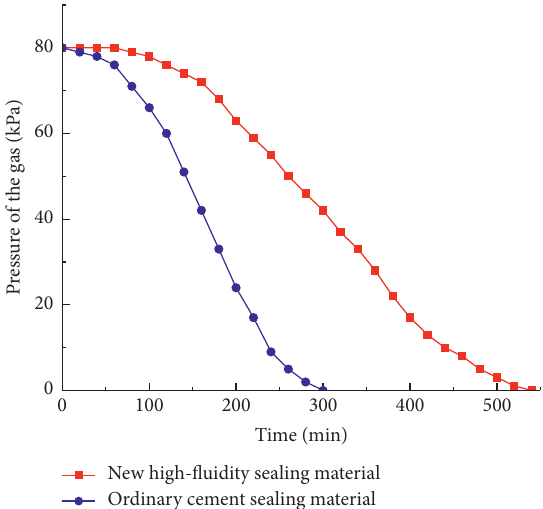
Figure 13: Air pressure change diagram of different sealing materials.